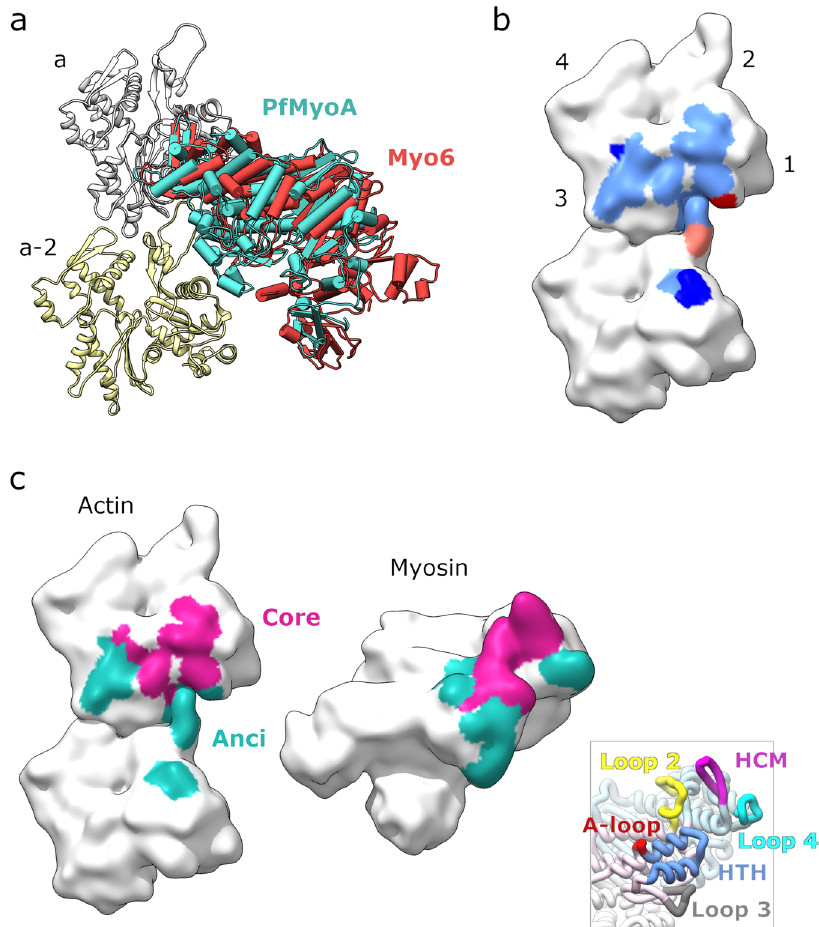
Fig. 4 Actomyosin interaction footprint analysis. a Overlay of the fi lament bound structures of PfMyoA (teal) and Myosin 6 (Myo6; red) revealing very similar orientations in relation to the fi lament. b Mapping of myosin footprints onto the actin fi lament surface. Two longitudinal neighboring actin monomers are shown. The subdomains are labeled in the upper monomer. The light blue region is contacted by all four myosins. The dark blue region is contacted by all myosins except for PfMyoA. The orange region is contacted by Myo1b and NM2c, the red region is contacted by NM2c only. c Mapping of the core (magenta) and ancillary (Anci, teal) interfaces as de fi ned by conservation of interactions (see Supplementary Table 2) onto an open-book representation with the actin- fi lament surface on the left and the myosin surface on the right. The inset in the lower right corner shows the primary myosin structural elements partaking in interactions in the same orientation (HCM: hypertrophic cardiomyopathy loop; HTH: helix-turn-helix motif; A-loop: activation